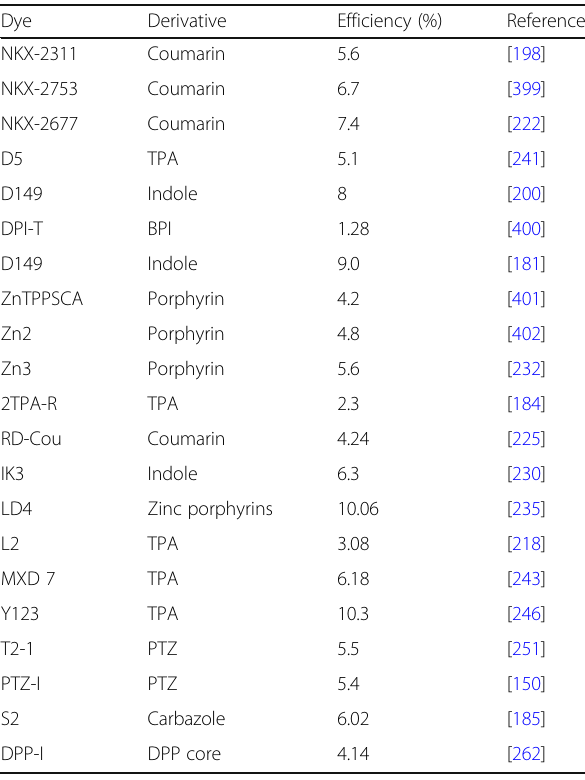
Table 4 The efficiency for DSSCs based on different metal-free organic dyes